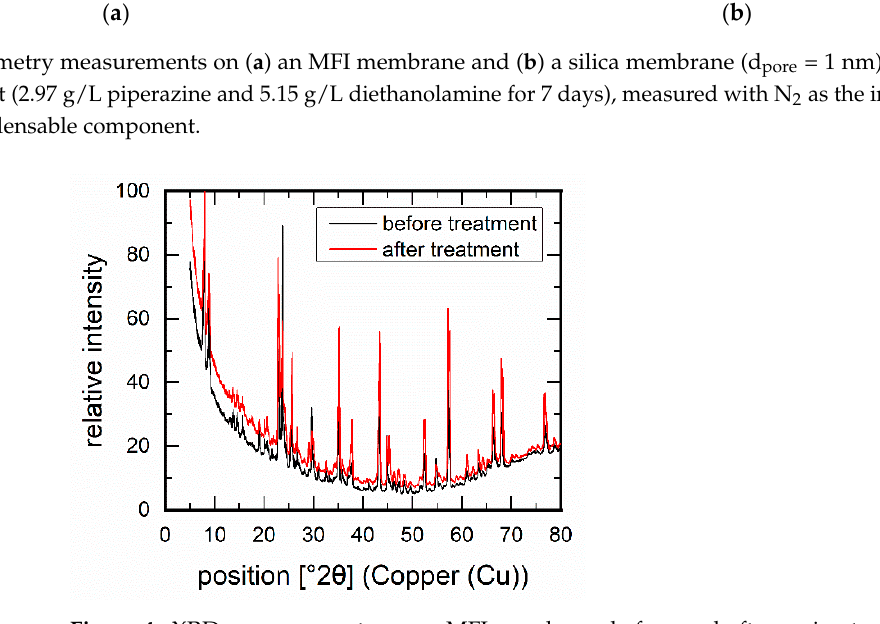
Figure 4. XRD measurements on an MFI membrane before and after amine treatment (2.97 g/L piperazine and 5.15 g/L diethanolamine for 7 days).